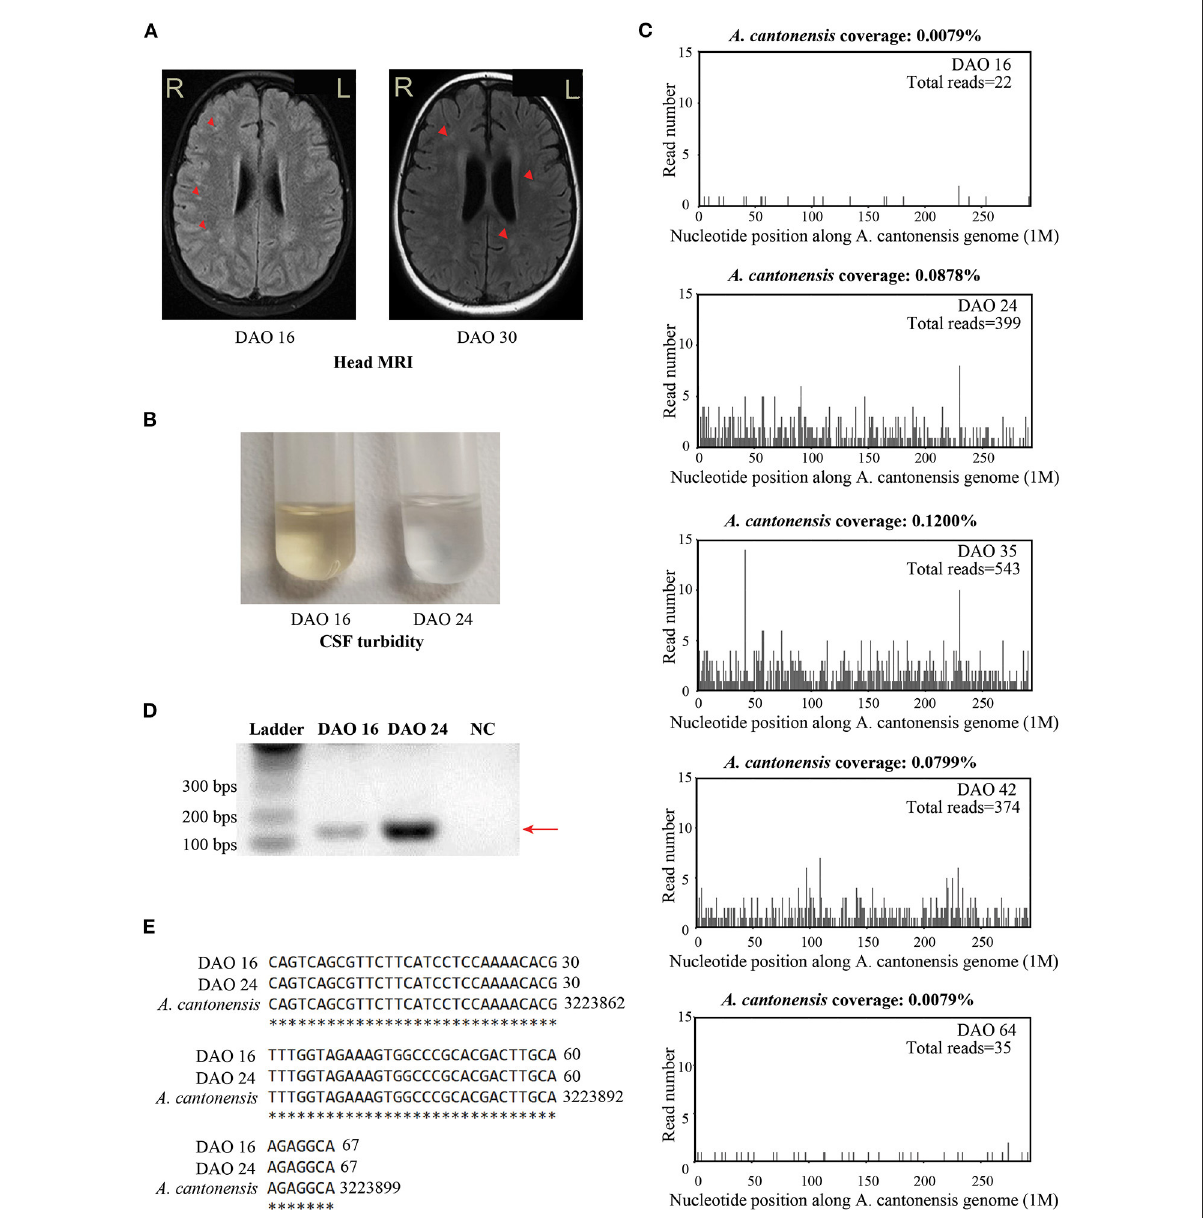
FIGURE2 The results of clinical tests during the treatment. (A) The brain MRI staining on DAO 16 and DAO 30. (B) The turbidity of CSF samples collected on DAO 16 and DAO 24. (C) The patient’s CSF mNGS coverages mapped to A. cantonensis genome on DAO 16, DAO 24, DAO 35, DAO 42, and DAO 64. (D) The diagram showing the bands of A. cantonensis- specific PCR from the CSF samples on DAO 16 and DAO 24 for Sanger sequencing. PCR primers sequences were designed against the genome sequence of A. cantonensis , given the sequencing result of the mNGS test: reverse primer: 5 ′ -AAACTGTCTTGCGGACACCT-3 ′ ; forward primer: 5 ′ -AAAGGCTCGTGTACCGCATT-3 ′ . The size of the PCR product is 168 bps, as pointed by the arrow, which is gel purified and subject to Sanger sequencing. Ultrapure water was used as the negative control. (E) Sanger sequencing alignment results between the purified PCR products and A. cantonensis DNA sequences (NCBI: txid6313) on DAO 16 and DAO 24. The asterisks indicate the consensus sequences. DAO, day after symptom onset; NC, negative